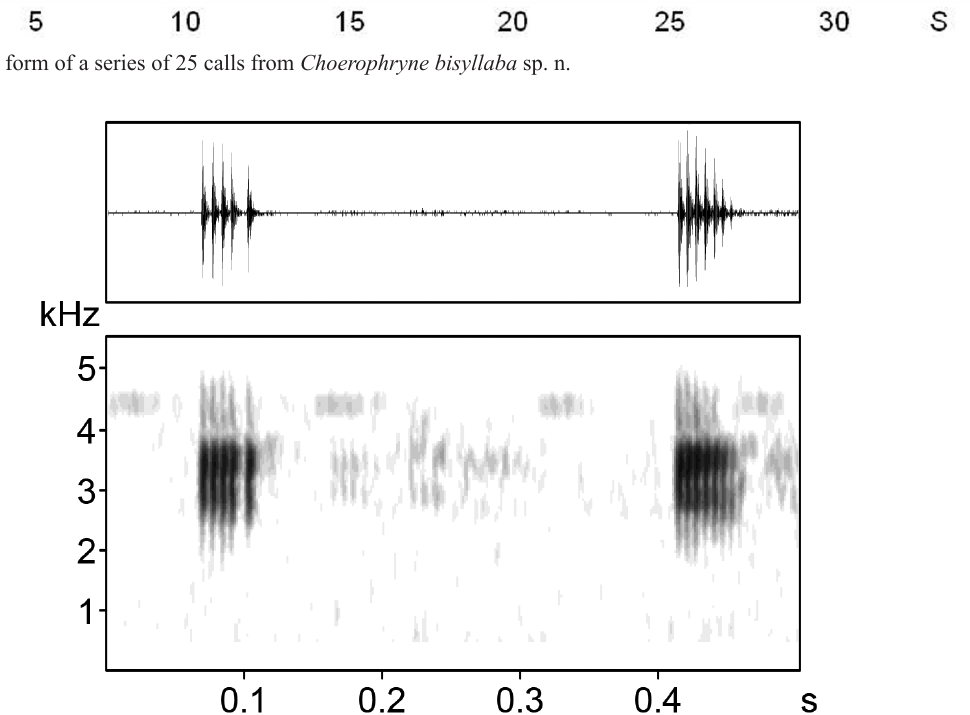
Figure 16. Wave form (above) and spectrogram (below) of an advertisement call from Choerophryne bisyllaba sp. n. consisting of two pulsed